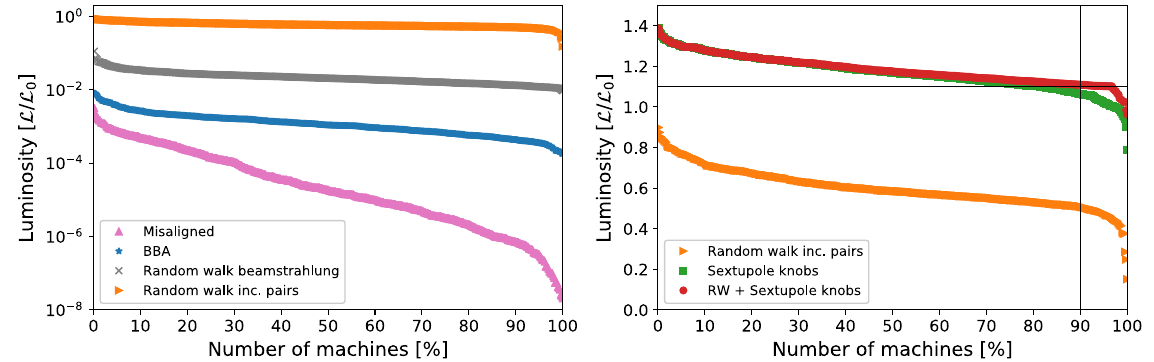
FIG. 7. Luminosity histogram after different steps of the tuning process. Left: The early steps of the tuning process. At the starting point, luminosity is ranging almost down to 8 orders of magnitude from the nominal values. Right: The final stages of the tuning (linear scale y axis). The straight lines mark the tuning goal: 90% of the machines should reach the target of 110% of nominal luminosity.